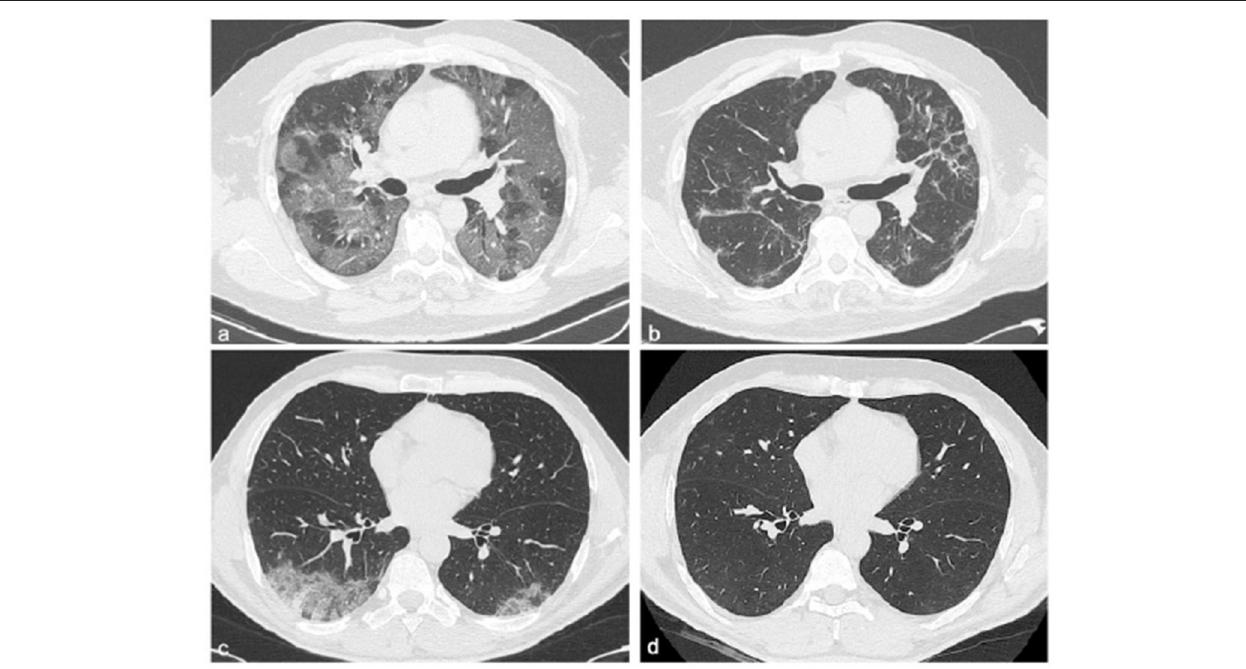
FIGURE 1 | Chest CT features of two patients with COVID-19 pneumonia at different time points: hospitalization and 6 months after discharge. Chest CT images of a 58-year-old male patient with COVID-19, not recovery patient (a,b) . The first CT performed at admission shows bilateral areas of ground-glass opacities in a peripheral distribution (a) , and after 6 months from discharge, CT shows persistent of interlobular septal thickening with peripheral distribution (b) . Chest CT images of a 51-year-old male patient with COVID-19, recovery patient (c,d) . The first CT shows, at admission, a small consolidation at the right lower lobe accompanied by ground-glass opacities in both lower lobes (c) , and after 6 months from discharge, no residual abnormalities were observed (d) .